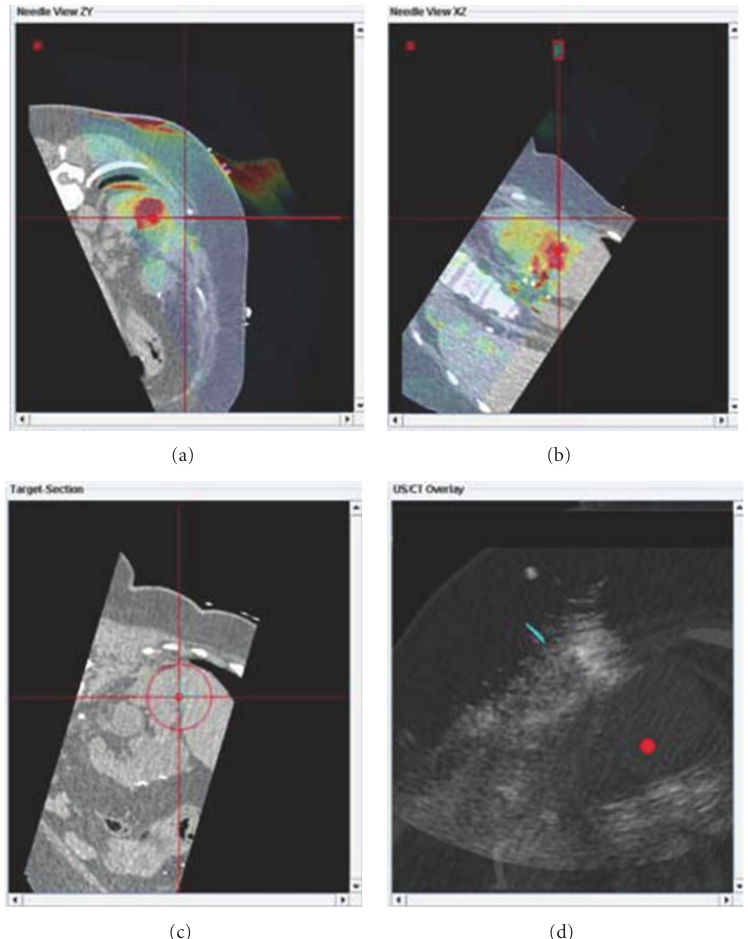
Figure 4: Fusion images combine procedural CT with MRI ((a) and (b) color images) and ultrasound (d) to display tumor target (red sphere (a) and (b) and red dot (d)). The tumor target is displayed in relation to the tracked needle location (cross hairs).